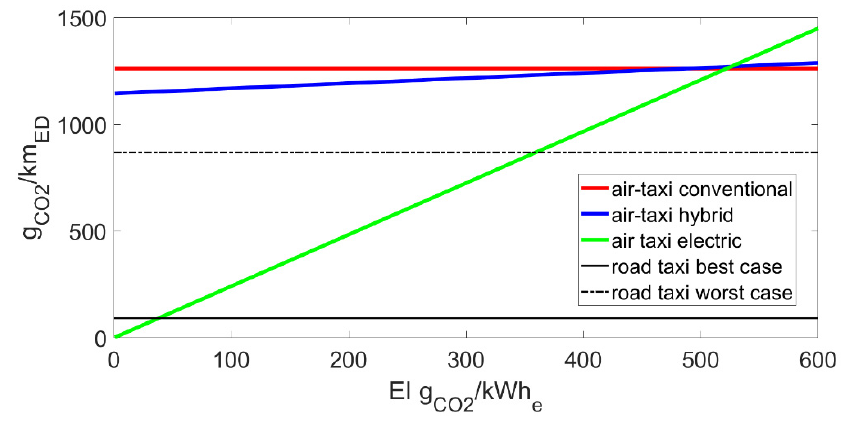
Figure 5. Comparison of WTW emissions of CO 2 per km of Euclidean distance with today technol-